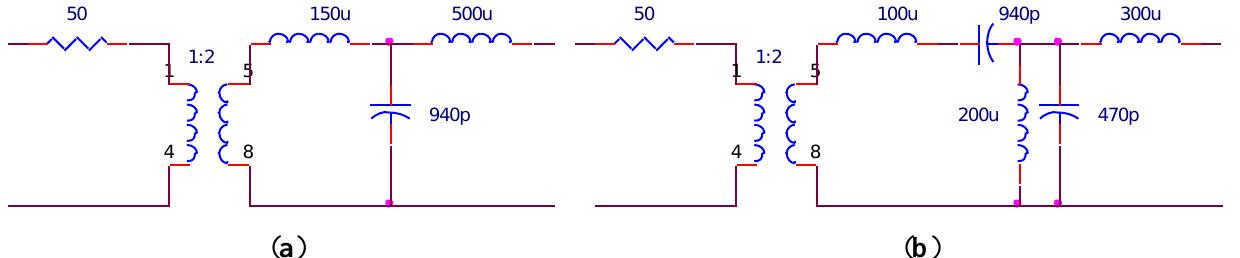
Figure 16. TPG of the EIMNs in Figure